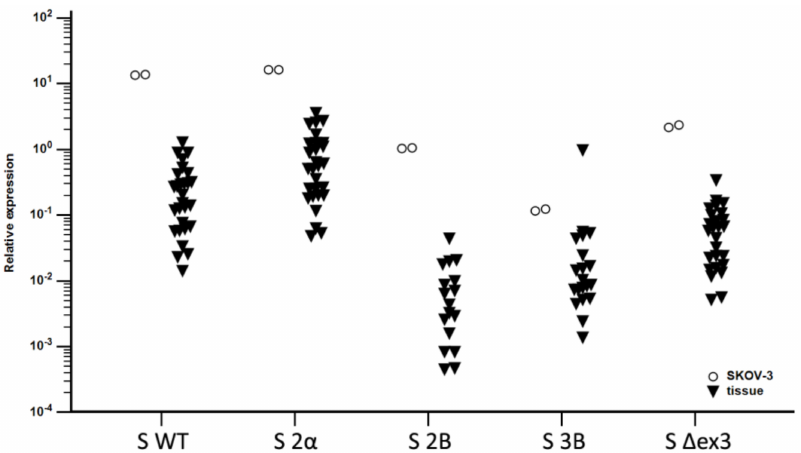
Figure 5. Relative expression of survivin isoforms in the SKOV-3 cell line (circles) and ovarian carcinoma (OC) tissue samples (triangles).